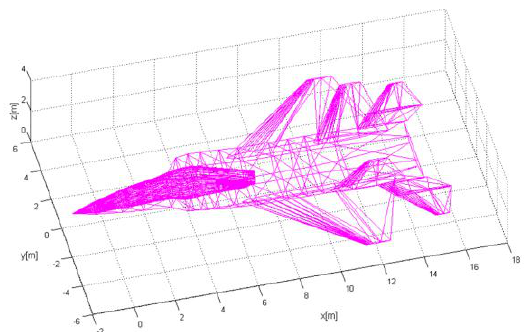
Figure 18. Target model as a input data of simulator